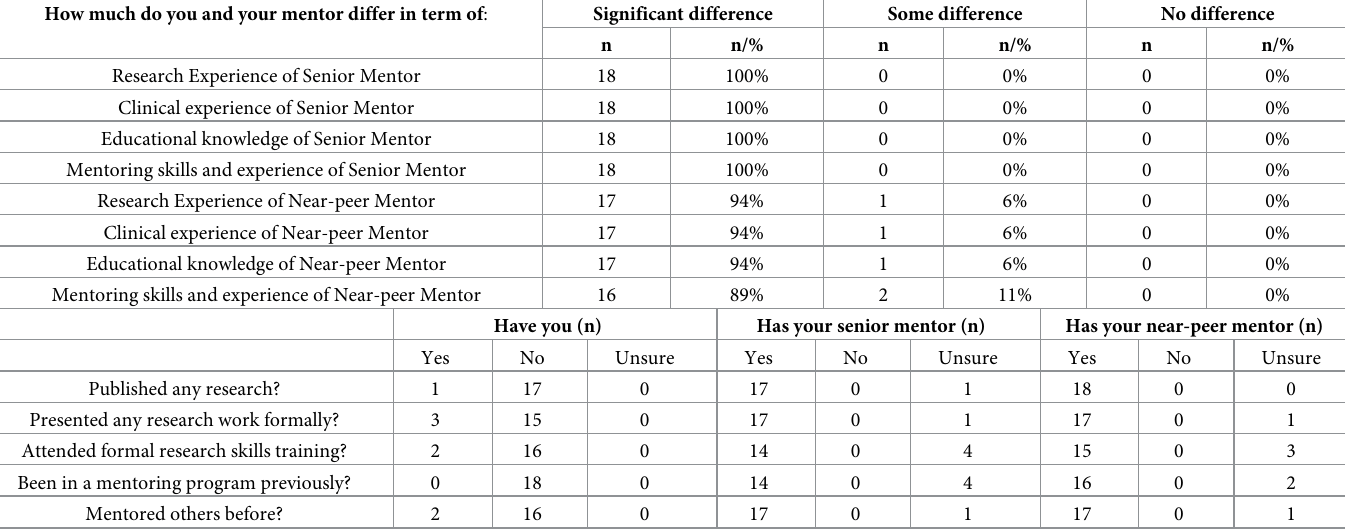
Table 4. Perceptions of research and mentoring experiences at the start of the program.